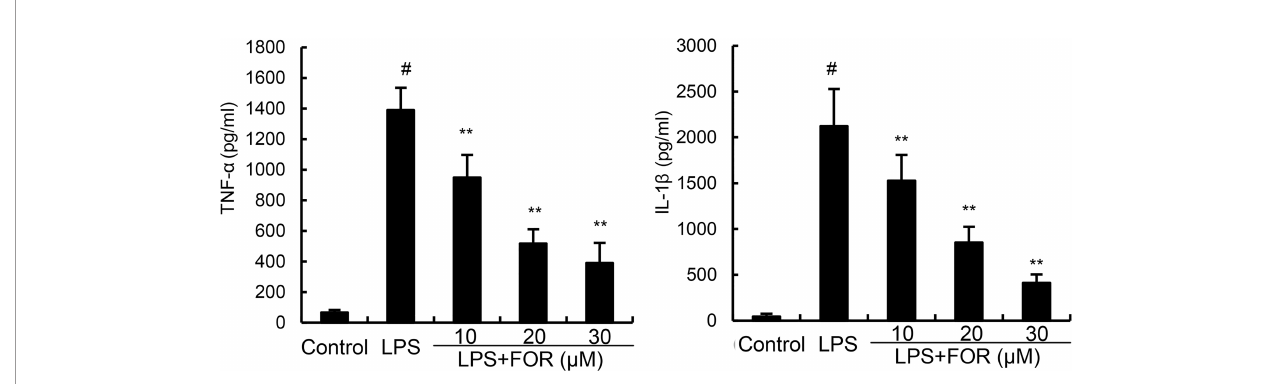
FIGURE 4 | FOR reduces LPS-induced secretion of TNF- a and IL-1 b in EpH4-Ev cells. The results herein are expressed as mean ± SEM of triple parallel measurements. # ( P < 0.01) is signi fi cantly different from control group; **( P < 0.01) is signi fi cantly different from